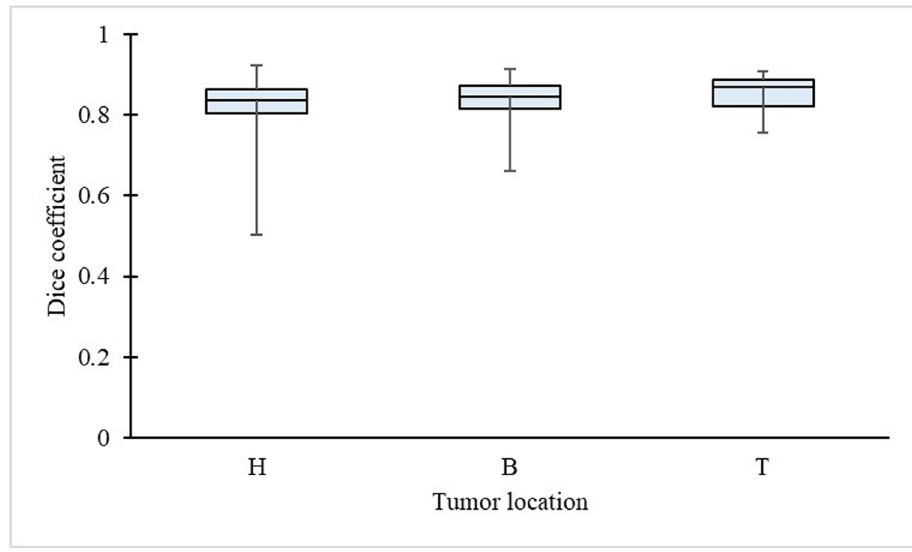
Fig 5. Tumor location and Dice coefficient of the pancreas. H means head, B means body, T means tail.